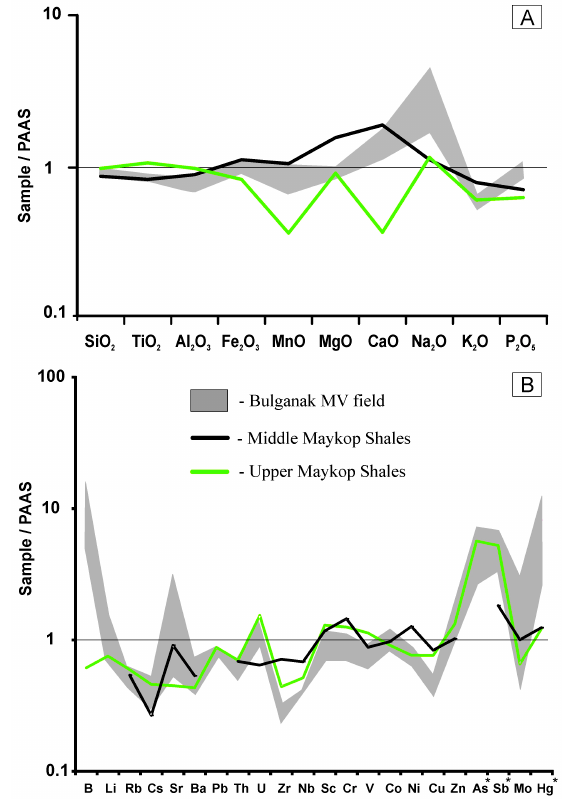
Figure 4. PAAS-normalised [75] major ( A ) and trace ( B ) element patterns of mud masses (Bulganak MV field) and Maykop parent rocks (Tables 1 and 2). * Upper crust-normalised [76] data.